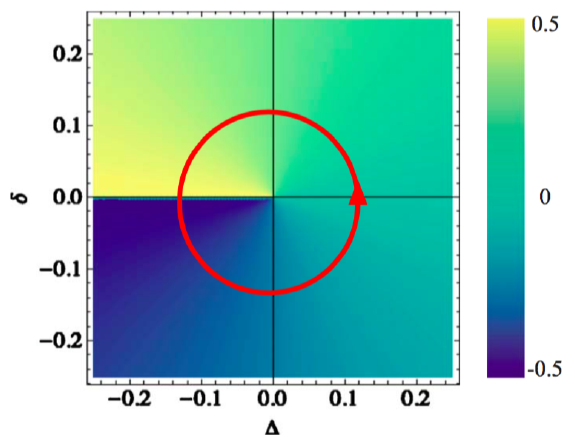
Figure 7: Polarization as a function of parameters ∆ and δ in the 1D Rice-Mele model. Here the units are ea where a is the lattice constant. The line of discontinuity can be chosen anywhere depending on the particular phase choice of the eigenstate. From Ref. [ 27 ]